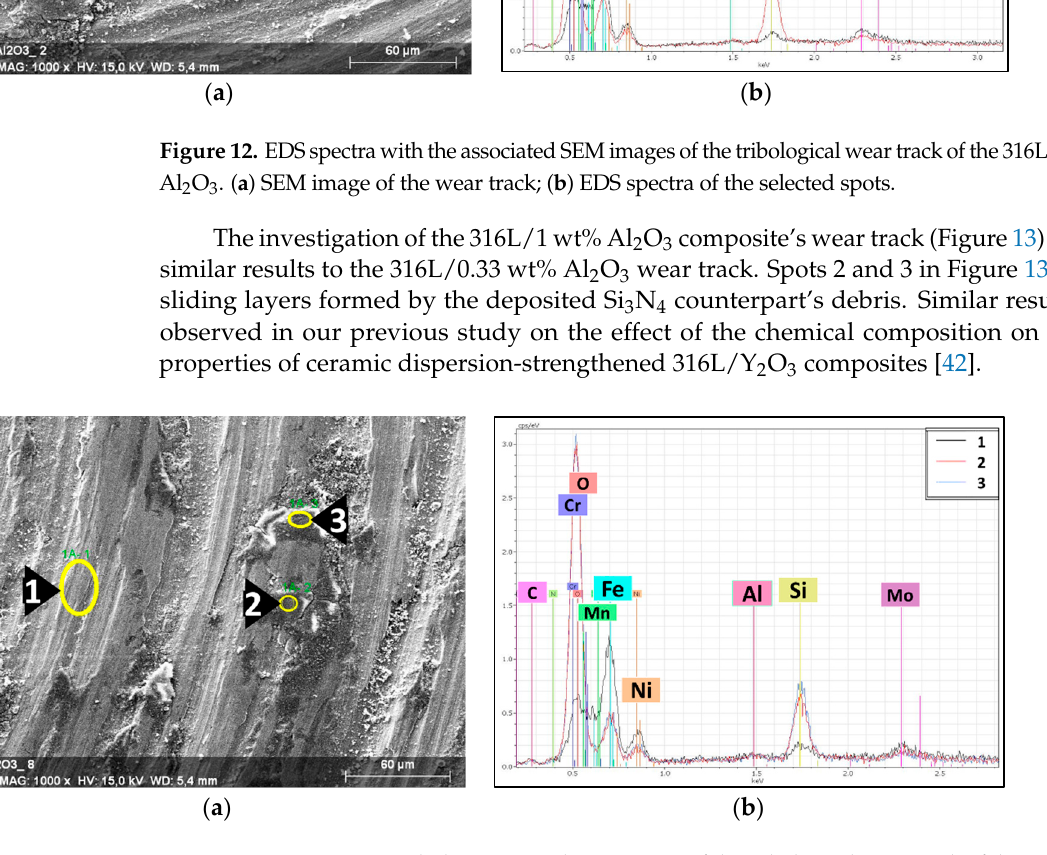
Figure 13. EDS spectra with the associated SEM image of the tribological wear track of the 316L/1 wt% Al 2 O 3 . ( a ) SEM image of the wear track; ( b ) EDS spectra of the selected